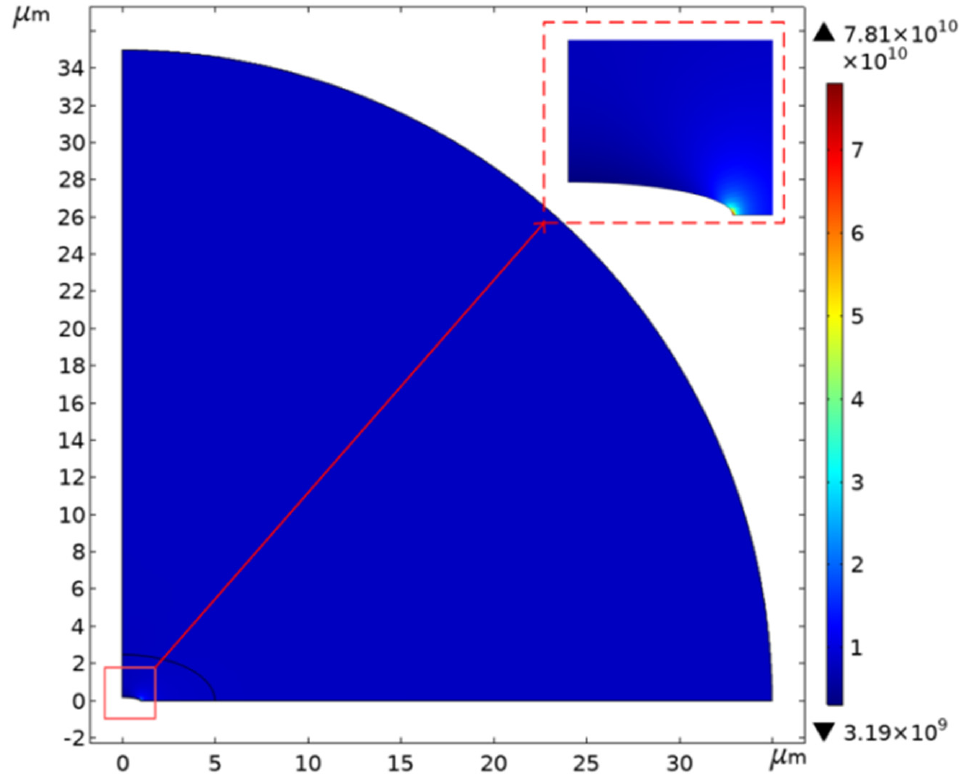
Figure 5. The simulation results of stress distribution around the elliptical hole.